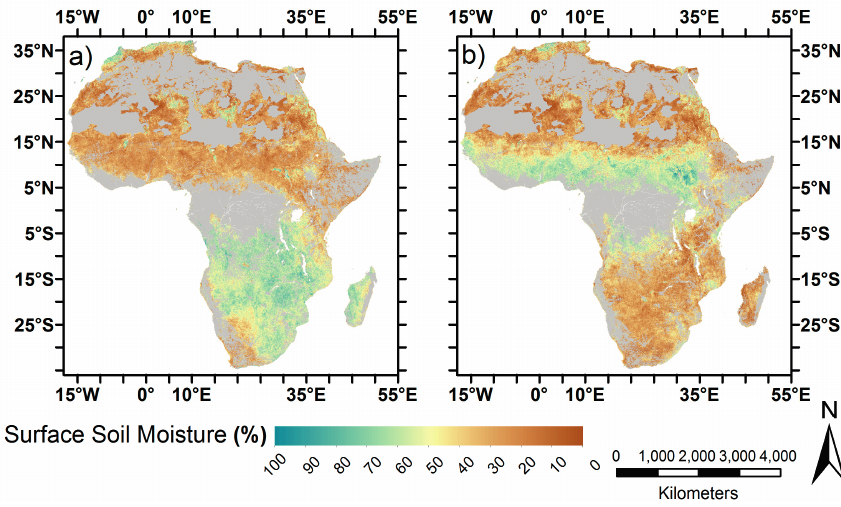
Figure 12. The 1-km Advanced Synthetic Aperture Radar (ASAR) Global Monitoring (GM) surface soil moisture monthly composites for ( a ) January and ( b ) October 2011. The grey color represents the masked